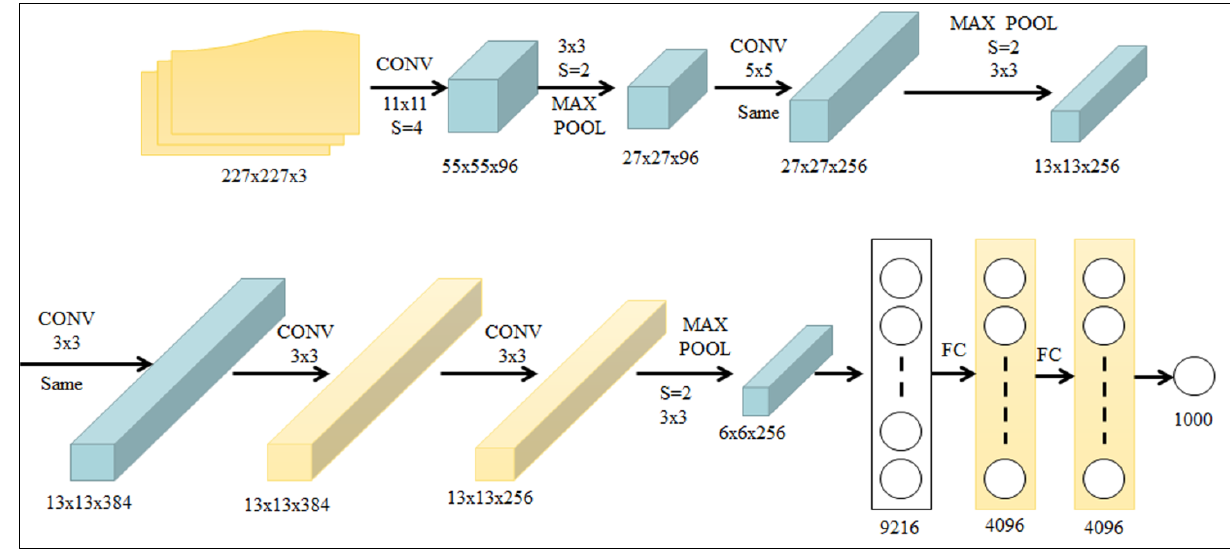
Figure 2: AlexNet